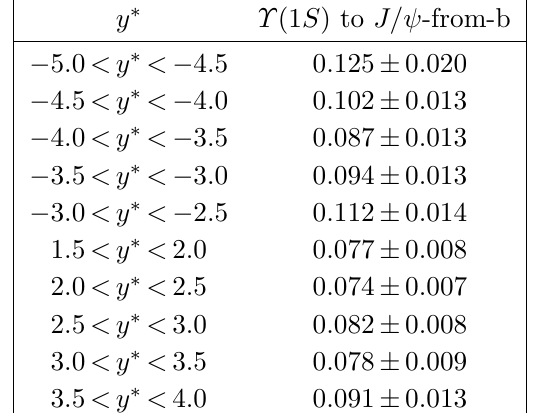
Table 20 lists the (cid:7) (1 S ) to nonprompt J= ratios in rapidity bins.